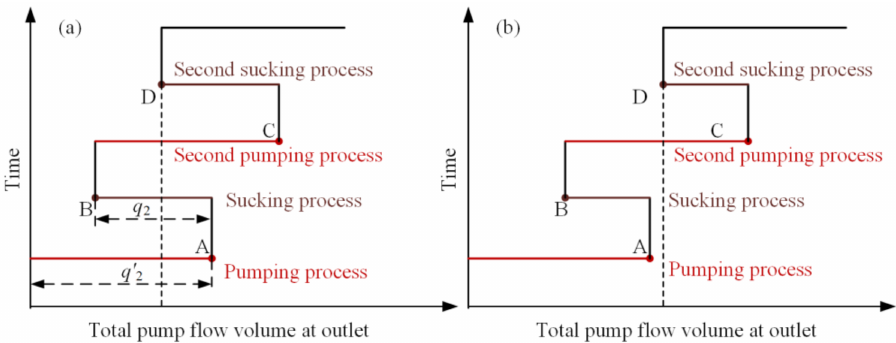
Figure 4. The total pump flow at outlet. ( a ) the flow characteristics with large reflux; ( b ) the flow characteristic with full forward